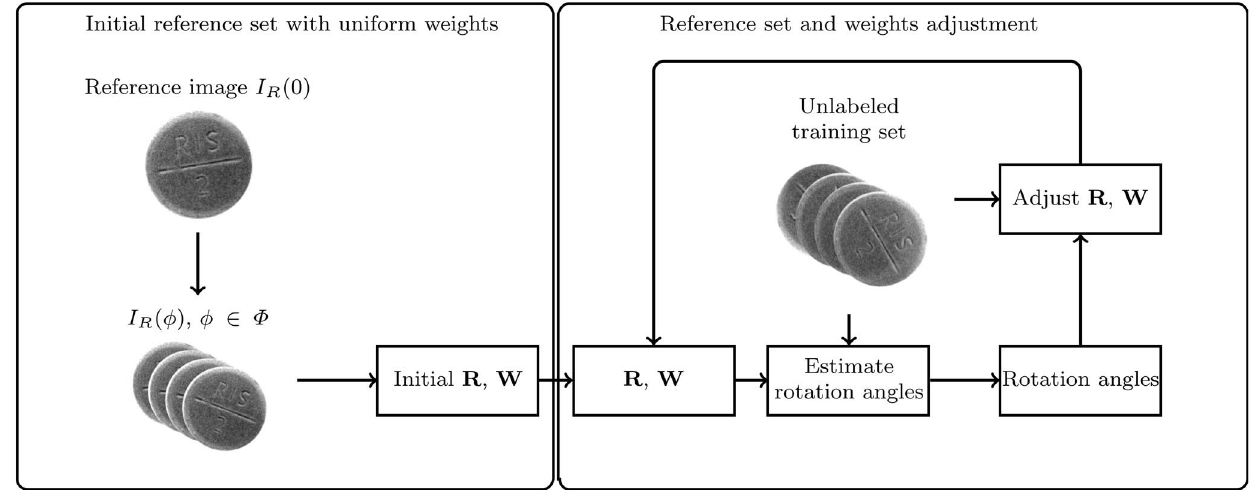
Figure 2. Training process. An initial weight and reference set estimations (left) are iteratively refined with a set of unlabeled training images (right). R and W denote reference and weights set respectively.